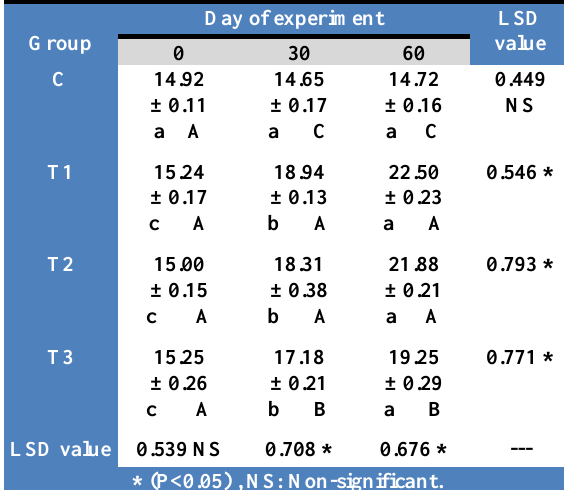
Table, 5: The effect of oral intubation for two months with sodium molybdate, sodium sulfate and their combination on (BUN) concentration (mg/dL) of adult male